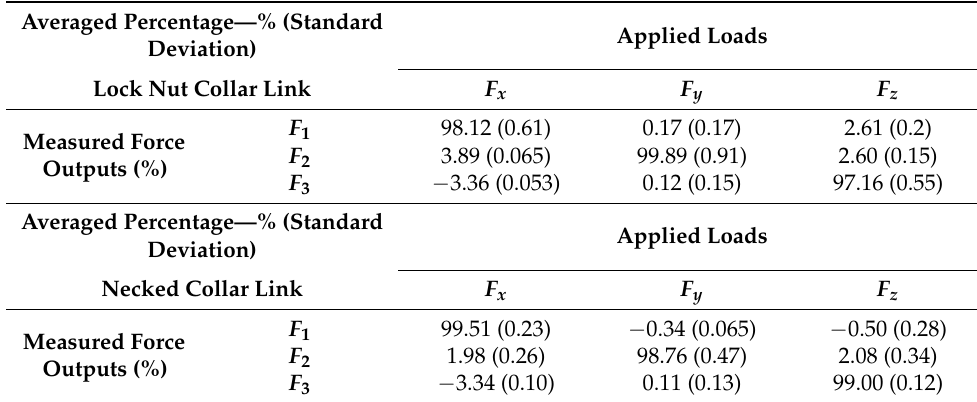
Figure 5. Calibration plot for system with necked collars. Table 1. Calibration matrices indicating distribution of loads applied in the directions x, y, and z onto sensors 1, 2, and 3. Locknut collar and necked collar